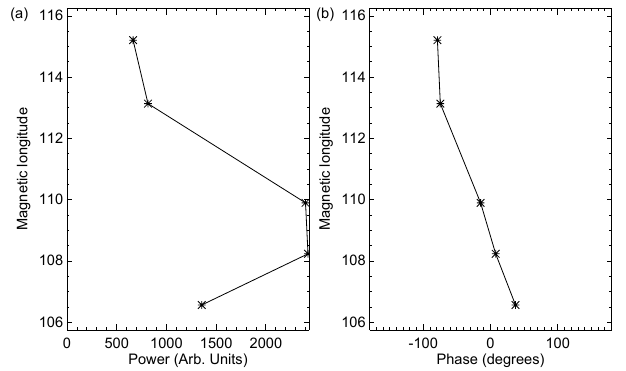
Fig. 6. Fourier (a) power and (b) phase at the peak frequency of the ULF wave observed in the ionospheric drift velocity mea- sured along beams 7–12 of the Hankasalmi SuperDARN radar at 70 ◦ magnetic latitude as a function of geomagnetic longitude.